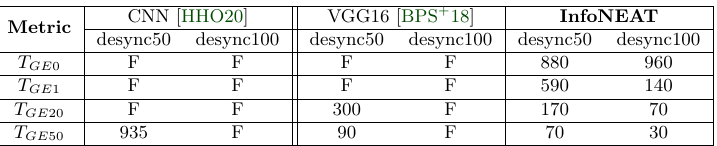
Table 5: NNs trained on ASCAD var sync against ASCAD var desync